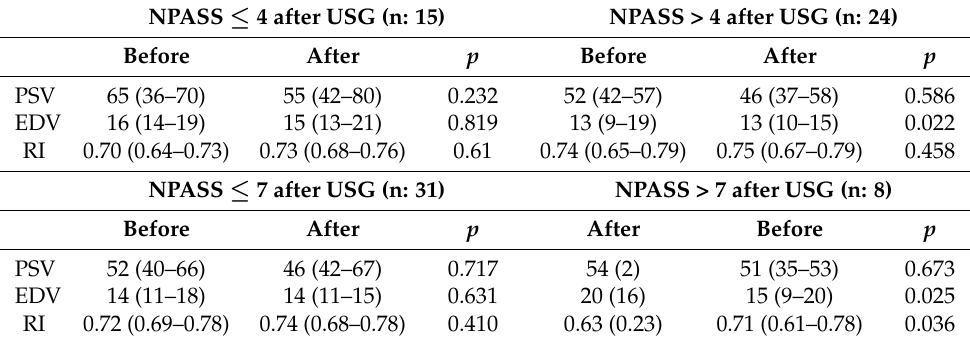
Table 5. Doppler ultrasonographic measurements of the patients when grouped according to the final pain scores. All measurements are given in medians, and 25th and 75th percentiles, as they were not normally distributed. Abbreviations: NPASS: Neonatal Pain, Agitation and Sedation Scale, USG: ultrasonography, PSV: peak systolic velocity, EDV: end-diastolic velocity, RI: resistive index. NPASS ≤ 4 after USG (n: 15) NPASS > 4 after USG (n: 24) Before After p Before